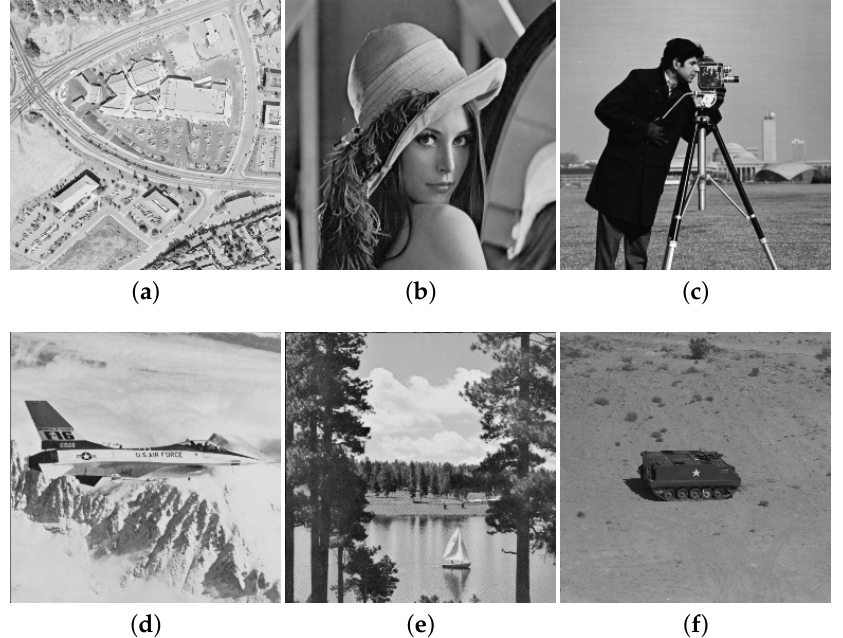
Figure 10. Result of decryption-procedure employed on encrypted standard images: ( a ) aerial; ( b ) lena; ( c ) cameraman; ( d ) jet; ( e ) lake; ( f )